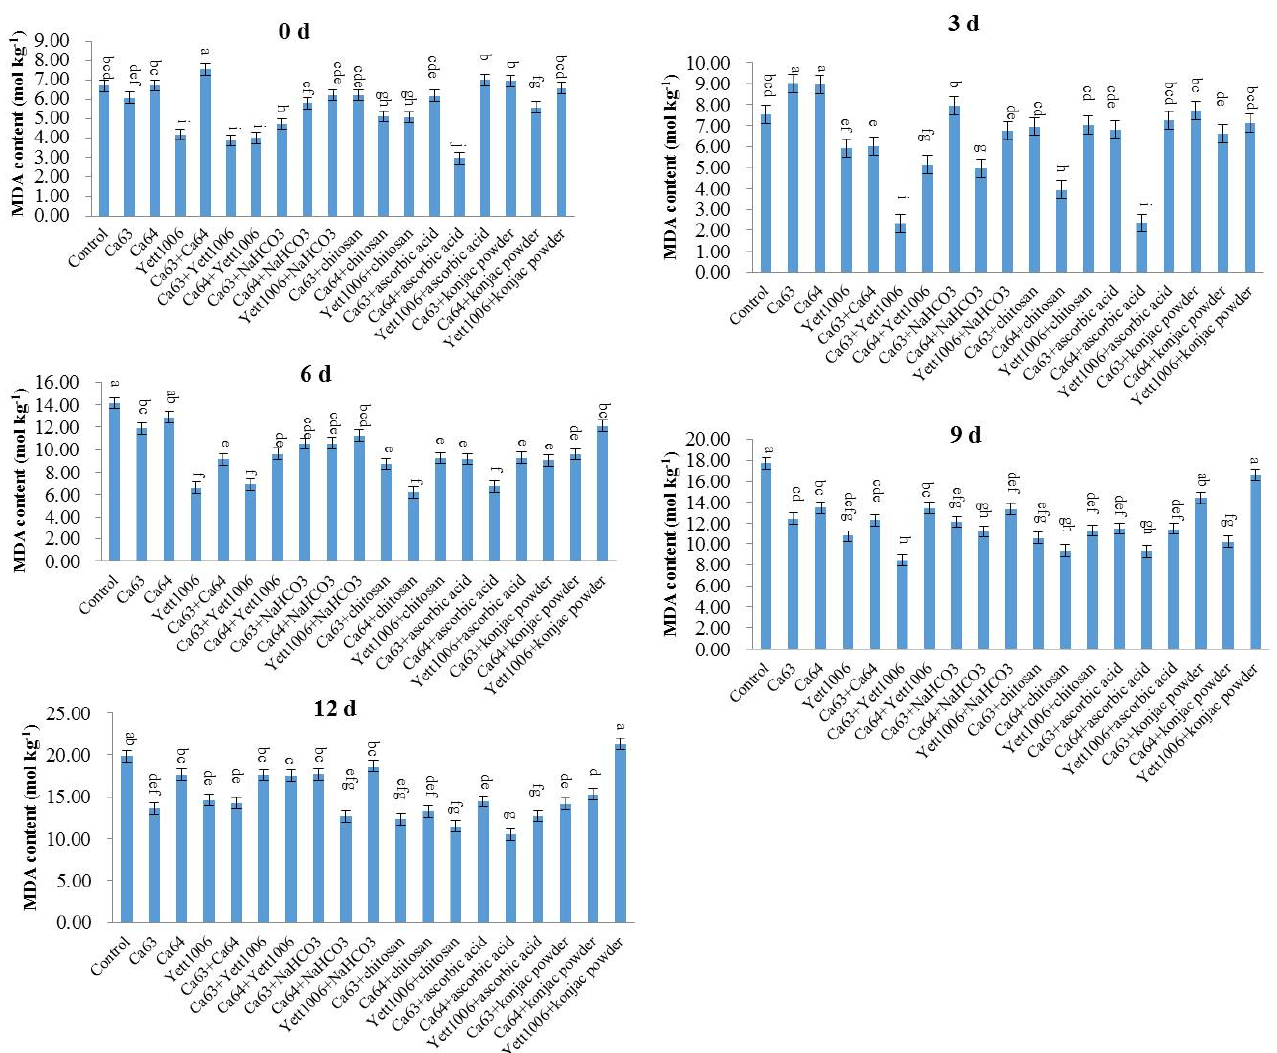
Figure 9. Evaluation of MDA content in snap beans between different treatments. Error bars represent the standard devi- ations of means ( n = 3). On the bars, the small letters indicate a significant difference in the treatment according to Duncan’s multiple difference test ( p < 0.05).